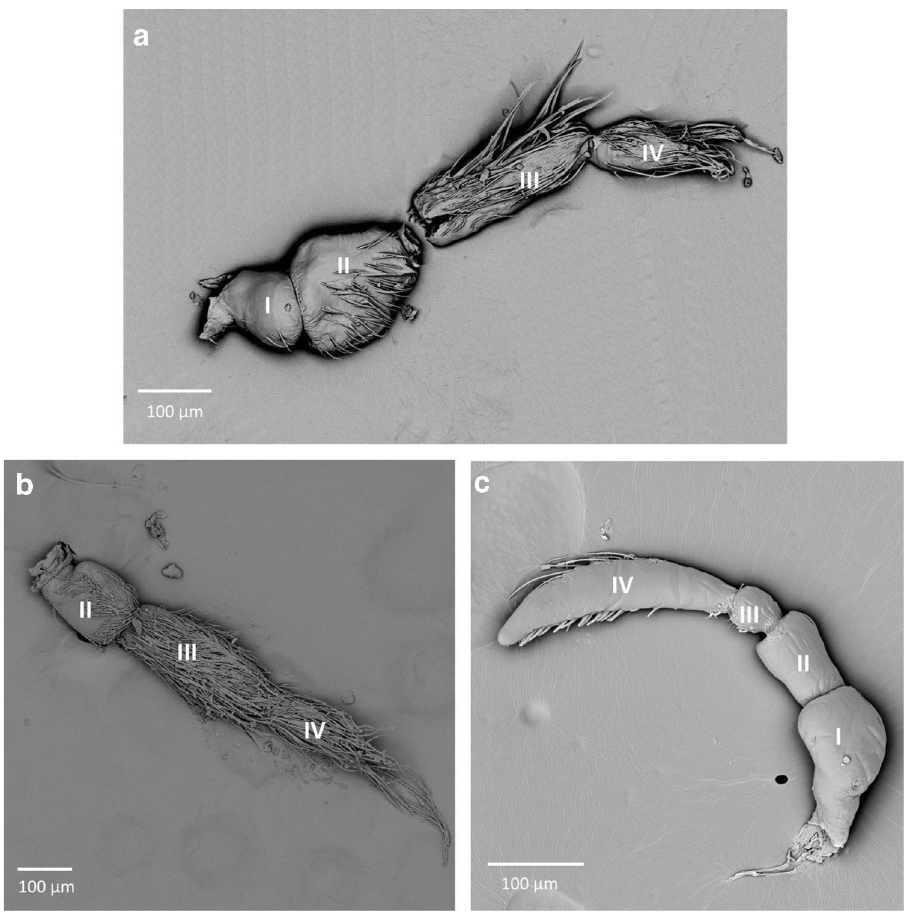
Figure 2. The antennae of Cryphocricinae; ( a ) Ambrysus fuscus , ( b ) Cataractocoris marginiventris , ( c ) Cryphocricos montei ; I–IV—numbers of